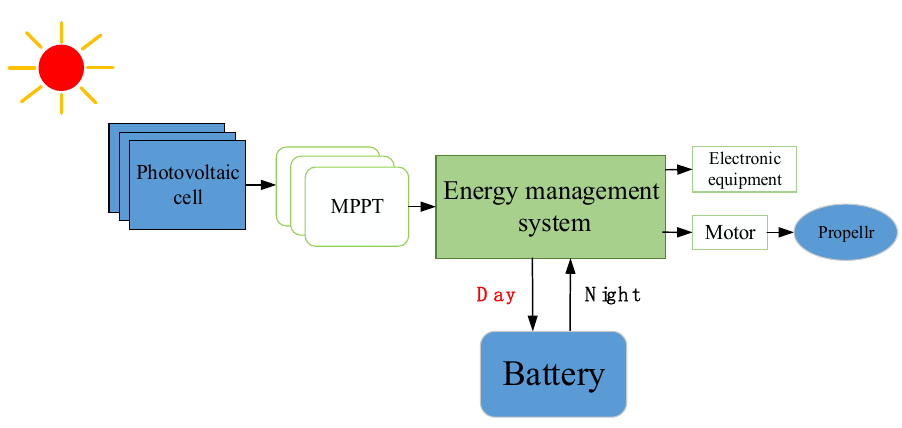
Figure 1. Schematic diagram of energy system for SPA.